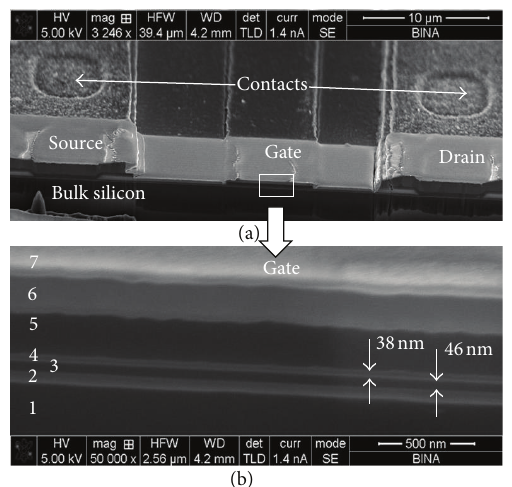
Figure 1: (a) FIB cross-section of the Ultrathin Body Device (UTB) (46nm channel thickness) showing the device structure including the source, gate, and drain regions. (b) Zoom-in of the layers below the gate region: 1; bulk silicon, 2; buried oxide, 3; silicon channel, 4; Nitride1/Gate Oxide, 5; polysilicon, 6; Silox2/Nitride2, and 7; FIB metal deposition.